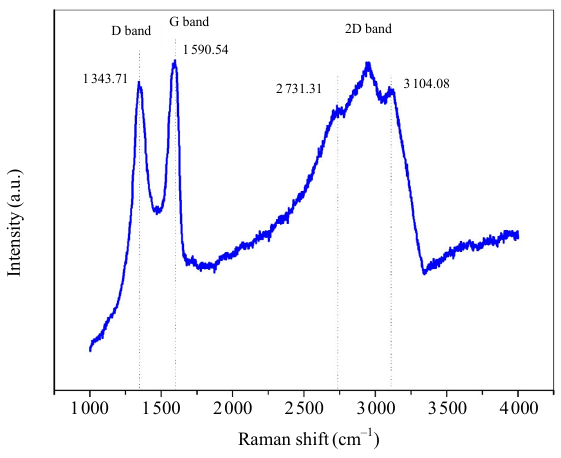
Fig. 6 Raman spectrum of the coated tapered